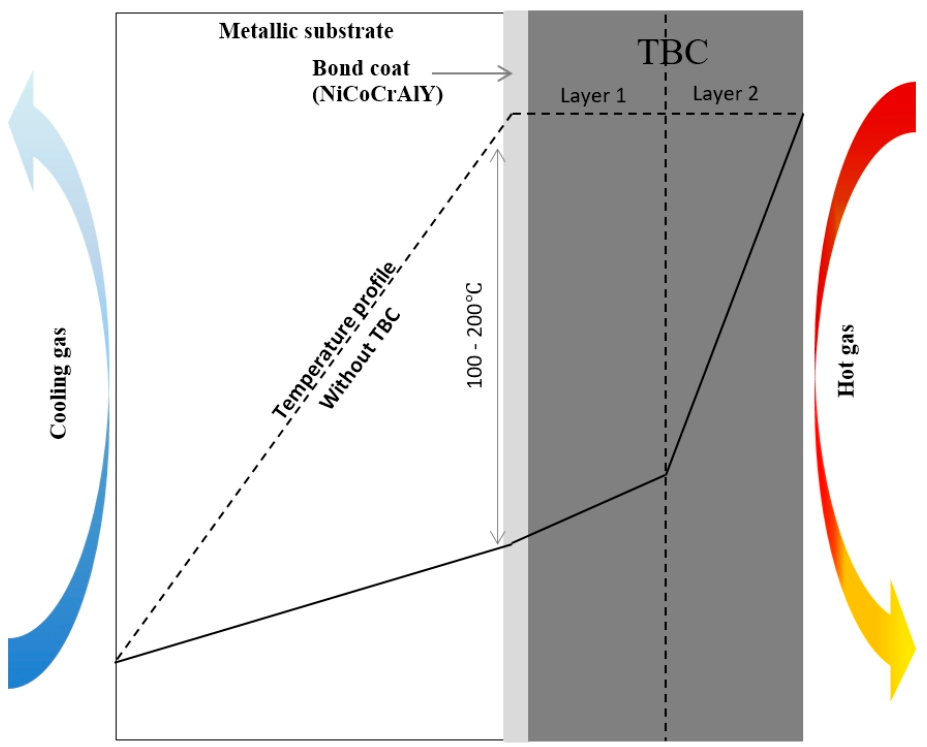
Figure 3. Schematic representation of ceramic thermal barrier coatings. TBC, thermal barrier coating.